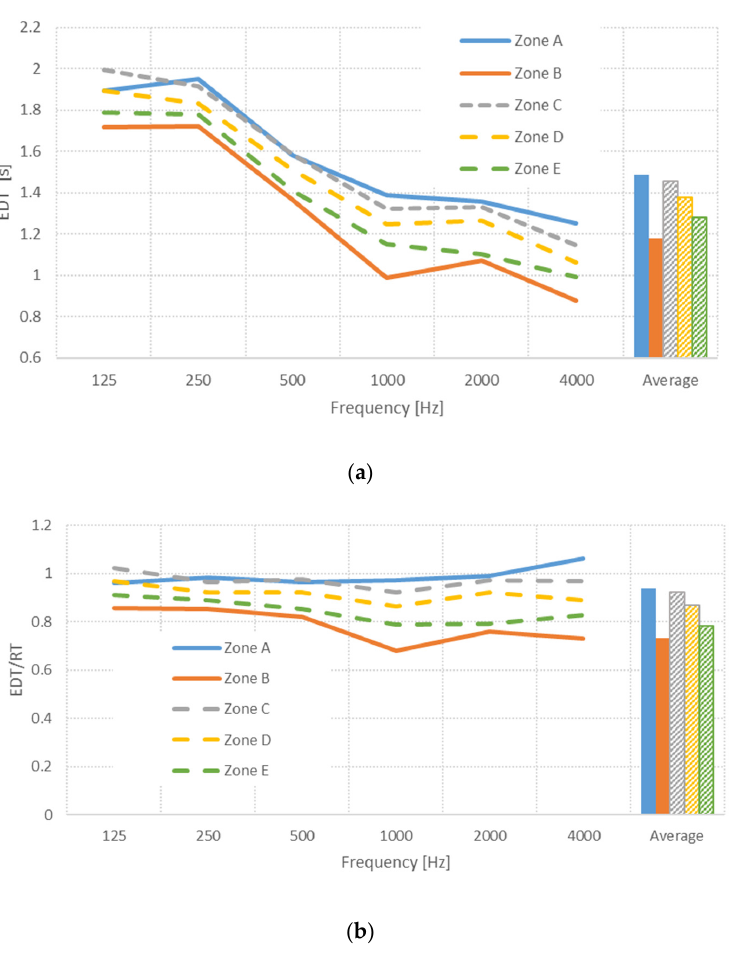
Figure 15. Early decay time ( a ) and relation RT/EDT ( b ) obtained in the auditorium, when the variable acoustic solution provides minimum absorption (configuration R), by zones.